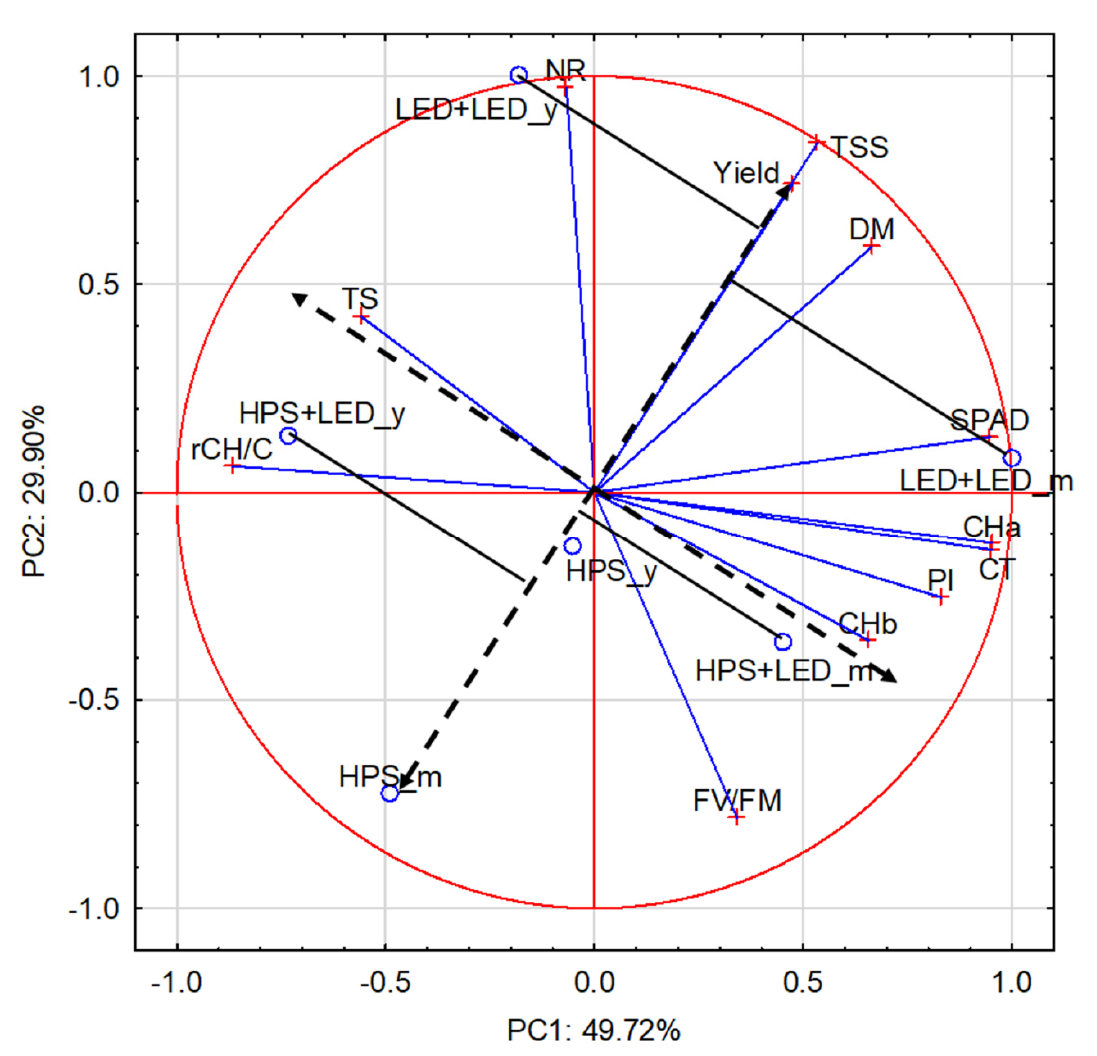
Figure 4. Biplot showing the location of the original features (variables) and the cases examined (supplemental lighting × leaf age) in the system of the first two principal components explaining 79.62% of the total variation. An additional coordinate system (dashed line) illustrates the relationship between the experiment factors and cucumber fruit yield. Crosses—markers for variables (features); circles—markers for cases (supplemental lighting × leaf age). HPS—high-pressure sodium lamps used as toplighting; HPS + LED—HPS toplighting and LED interlighting; LED + LED—light-emitting diode lamps used as toplighting and interlighting; y—young leaves (upper leaves); m—middle-aged leaves (medium and lower leaves). Leaf quality traits: CHa—chlorophyll a ; CHb—chlorophyll b ; CT—total carotenoids; DM—dry matter; FV/FM—maximum quantum efficiency of PSII; NR—nitrate reductase activity; PI—Performance Index; rCH/C—Pearson correlation coefficient between distribution of chlorophyll and carotenoid fluorescence; SPAD—relative chlorophyll content; TS—total sugars; TSS—total soluble solids.